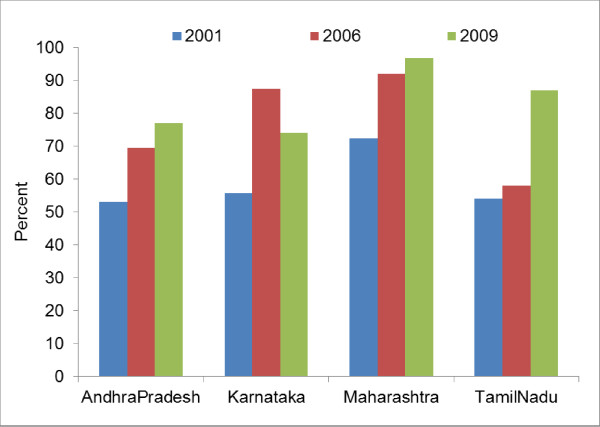
Female sex workers reporting consistent condom use in the last 30 days during commercial sex acts.